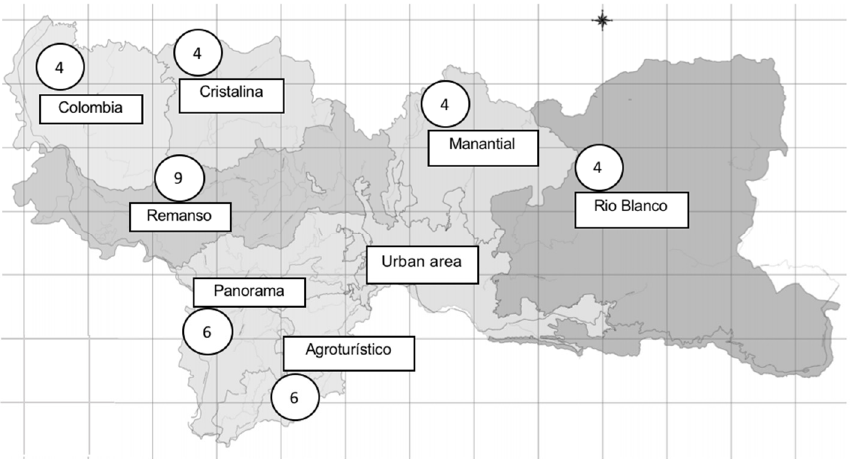
Figure 1. Number of detectors distributed in each jurisdiction of the rural area of the municipality of Manizales, Colombia. January to June 2020. Source: Alcald í a de Manizales, Secretar í a de Planeaci ó n, Gesti ó n de informaci ó n Geogr á fica.